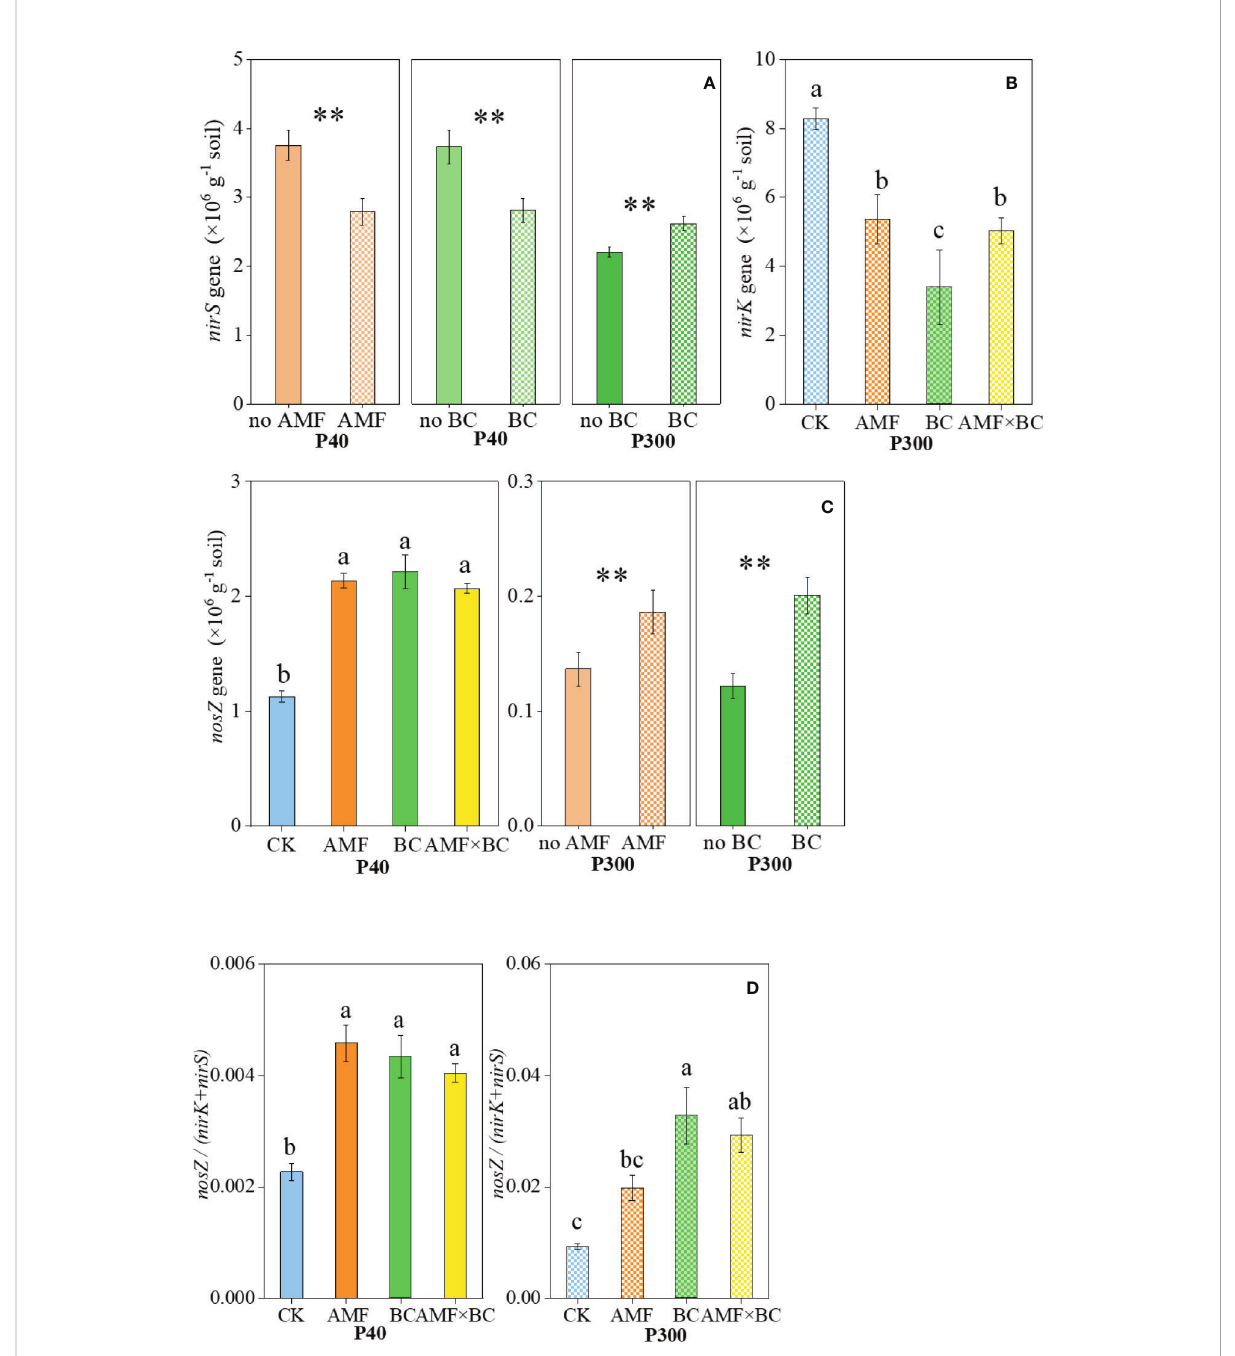
FIGURE 4 Variation in the (A) nirS, (B) nirK, and (C) nosZ gene copy numbers and (D) the ratio of nosZ/(nirK+nirS) as in fl uenced by P rates (40 and 300 mg kg − 1 soil) and AMF and BC additions. Each value is the mean of fi ve replicates (±SE). For a given P rate, different letters in each graph denote signi fi cant difference among treatments (P ≤ 0.05). ** P < 0.01. Note an order of magnitude difference in the scale on the